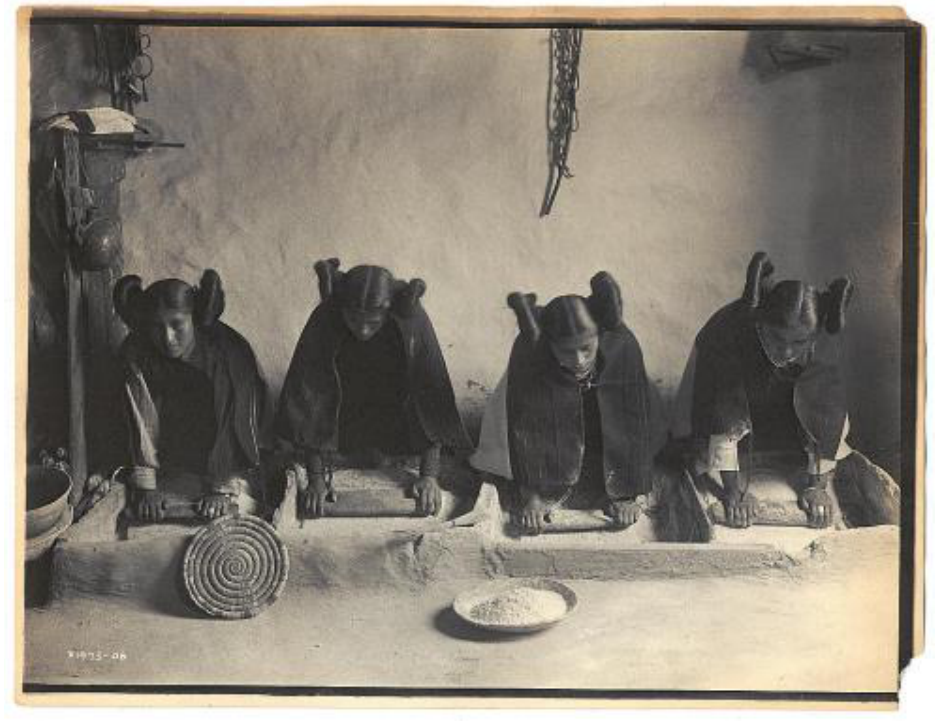
Figure 7 Edward S. Curtis, The mealing trough – Hopi , ca. 1906. Digital file from original. Library of Congress, Prints & Photographs Division, Edward S. Curtis Collection, [LC-DIG-ppmsca-05085]. Recent scholarship on Curtis seeks to move beyond the critique of his posing and staging activities because, as Aaron Glass notes, “it has tended to grant Curtis sole authorship and control, completely ignoring the active participation and possibly strate gic agency of the indigenous people who chose to sit and post and dress up for him.” 34 Glass instead examines the motivations of Kwakwaka ’wakw sitters pictured in Volume Ten of Curtis’s extensive book series The North American Indian . He focuses on George Hunt, a figure of English and Alaskan Tlingit descent who married into the Kwakwaka ’wakw, concluding that Hunt’s own ethnographic interests as well as his desire to fit into his wife’s culture likely influenced his decision to pose for Curtis. In a similar singular study of a sitter, Shamoon Zamir analyzes Curtis’s portrait of Alexander B. Upshaw, a Crow man who studied at the Carlisle Indian School, married a white woman, and became a respected advocate for tribal rights (fig. 8). In earlier portraits, Upshaw is depicted in a suit and tie, hair